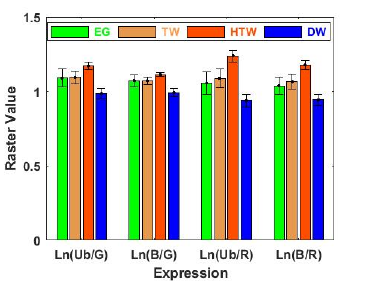
Figure 6. Mean values of each bathymetric ratio for each class for both images The training areas of the September image were also used to assess the class spectral separability using the J-M distance computed with the 6 first Landsat-8 OLI bands (Table 4).